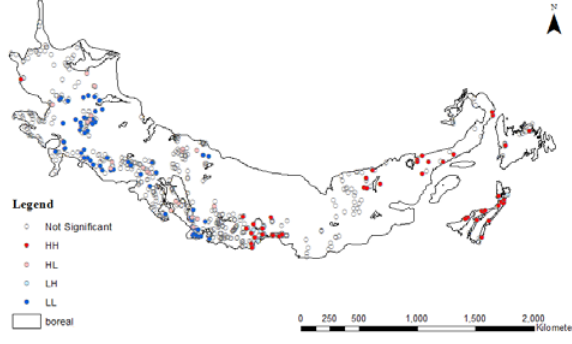
Figure 10. LISA cluster map of SOC levels in Boreal eco-region The SOC distribution pattern in the Cool Temperate eco-region is mainly characterized by a single HH cluster and LL cluster (Figure 11). Soil samples with high organic-carbon stock are clustered in the St. Lawrence watershed, which receives the highest level of precipitation. The LL cluster is observed around Prince Edward Island (PEI). Figure 11. LISA map of Cool Temperate eco-region SOC